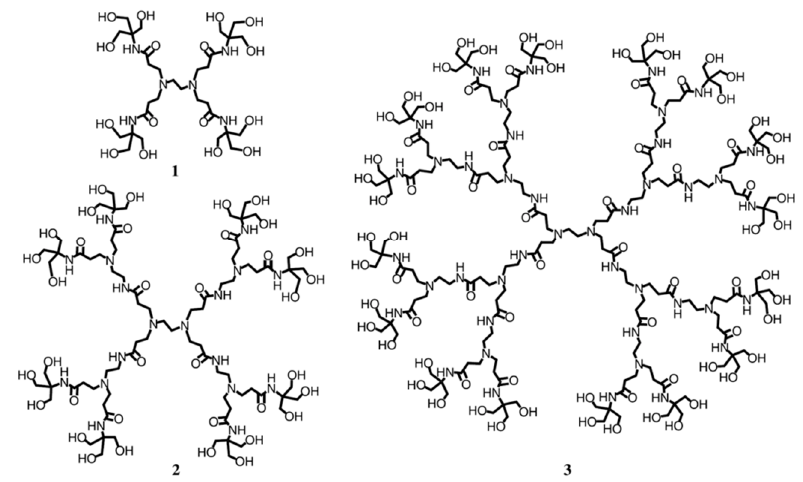
Figure 22. Two dimensional structures (i.e., 1,2,3) of [Core: EDA]; dendri-poly(amidoamine)- (tris-hydroxyl) 4-16 ; (G0,1,2); (PAMAM) dendrimers. Reprinted with permission from [62]. Copyright 2003 Elsevier.